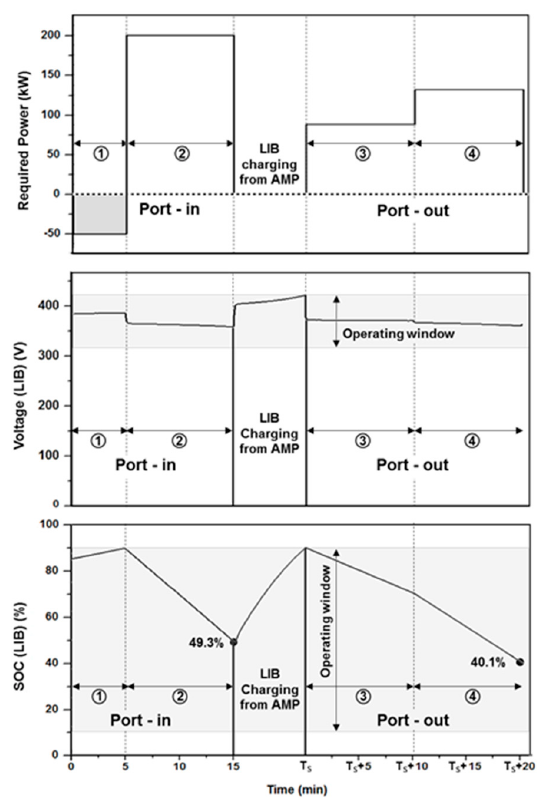
/ out mode). Figure 8. LIB pack voltage and state of charge (SOC) changes (port in/out mode).